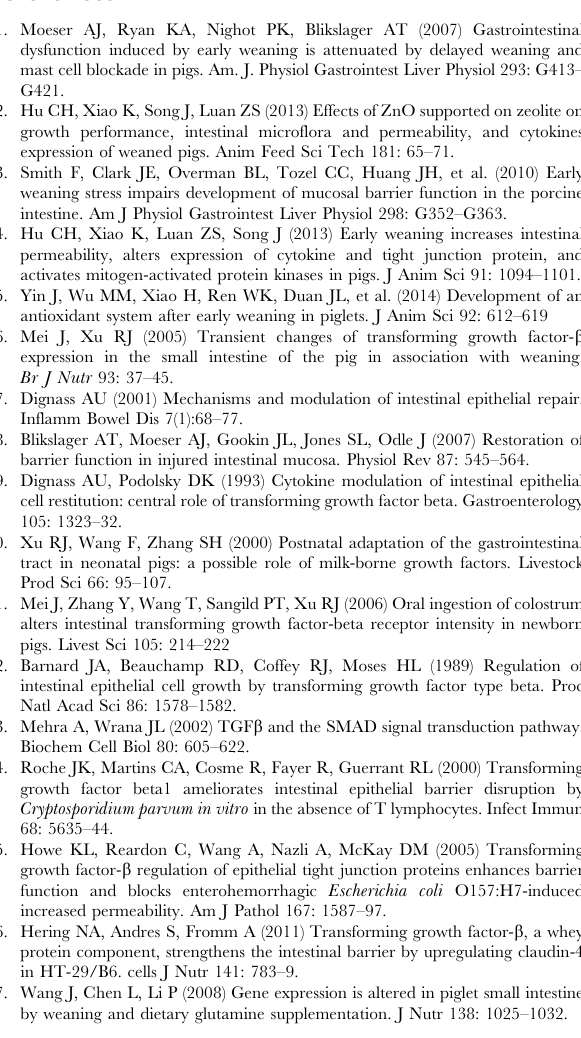
Means within a row with different letters differ significantly ( P , 0.05). 1 The 2 2 DD Ct method was used to analyze the relative expression (fold changes), calculated relative to the values in samples from the preweaning (d 0 postweaning) pigs. Data are means of six pigs. 2 Standard error of the